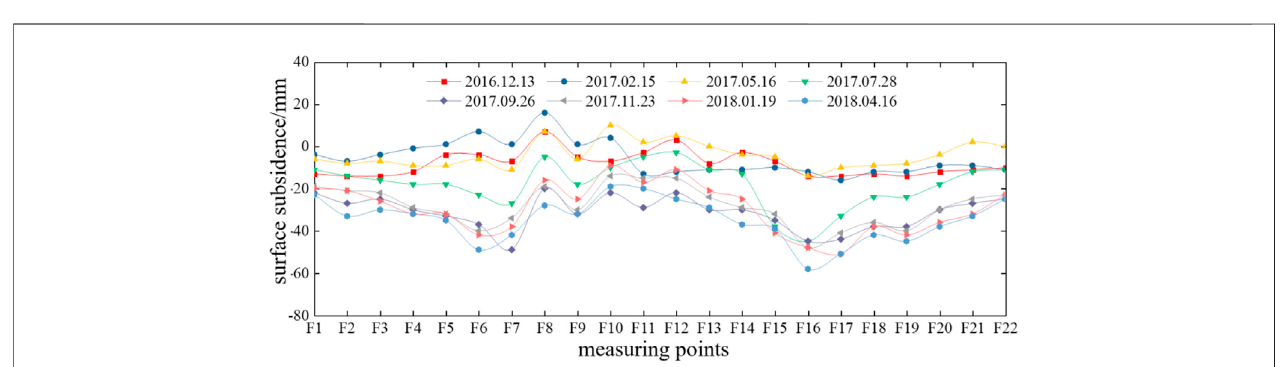
FIGURE 11 | Surface subsidence monitoring results.